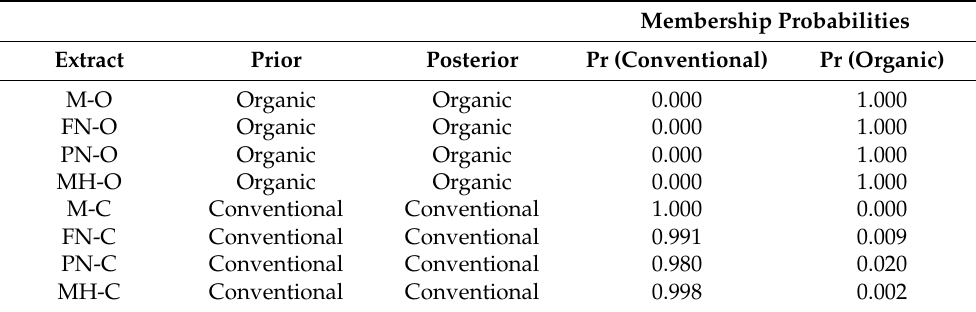
Table 8 and Table S13–S15 list the PC-DA results obtained based on the FTIR spectral data. The corresponding results based on Raman spectral data are presented in Table 9 and Table S16–S18. Table 9. Prior and posterior classification of the red grape pulp extracts using PC-DA (FTIR spectral